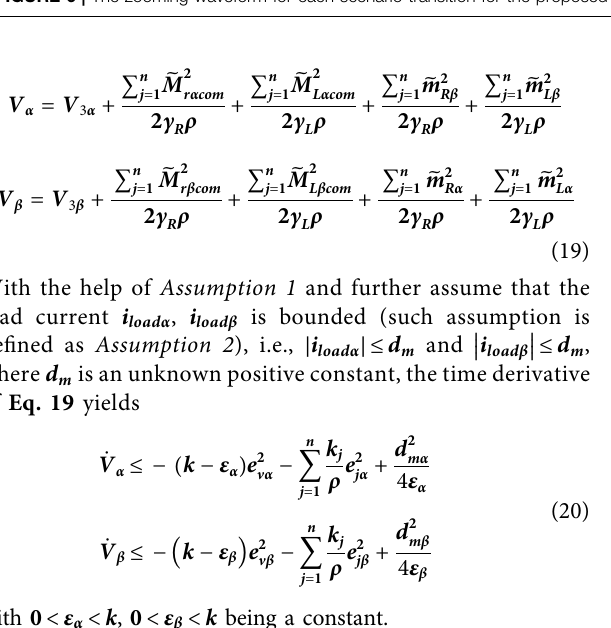
FIGURE 6 | The zooming waveform for each scenario transition for the proposed